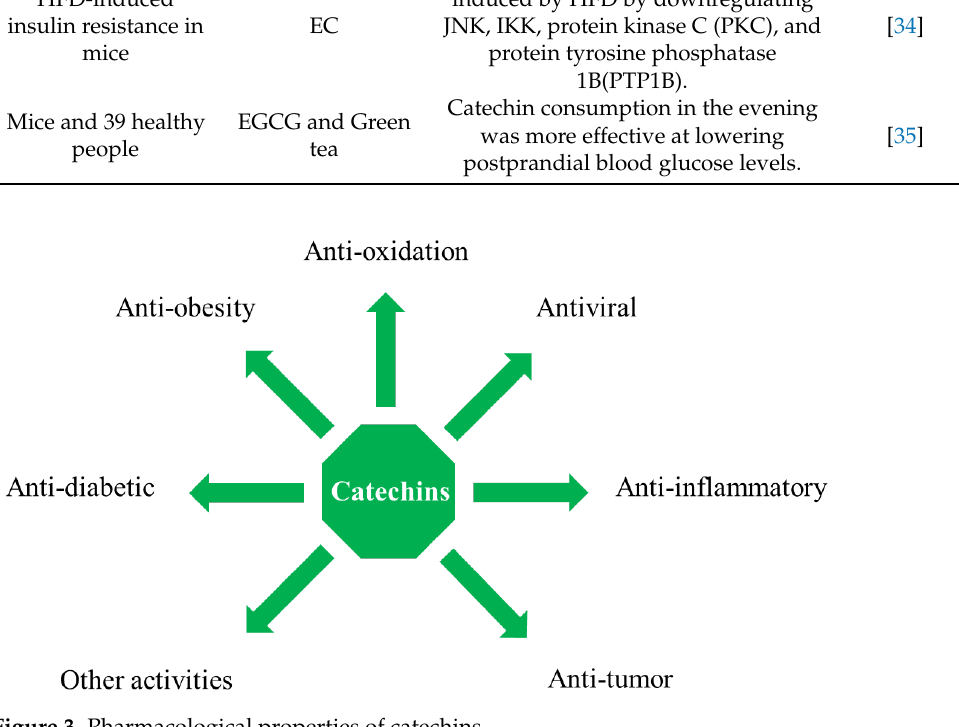
Figure 3. Pharmacological properties of catechins. Table 1. Improvement of diabetes through catechins.